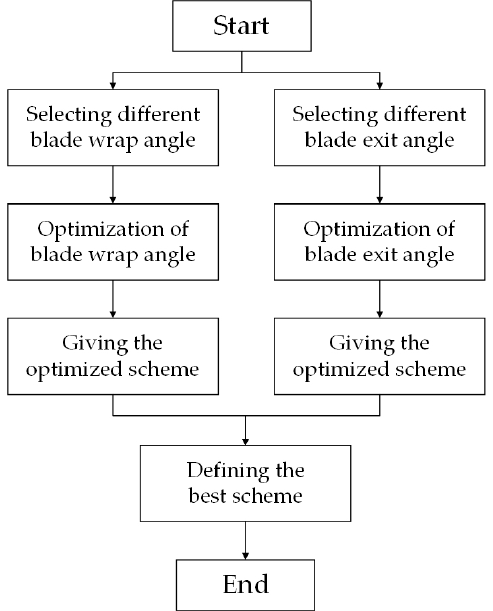
Figure 3. Flow chart of the optimized design of the impeller.